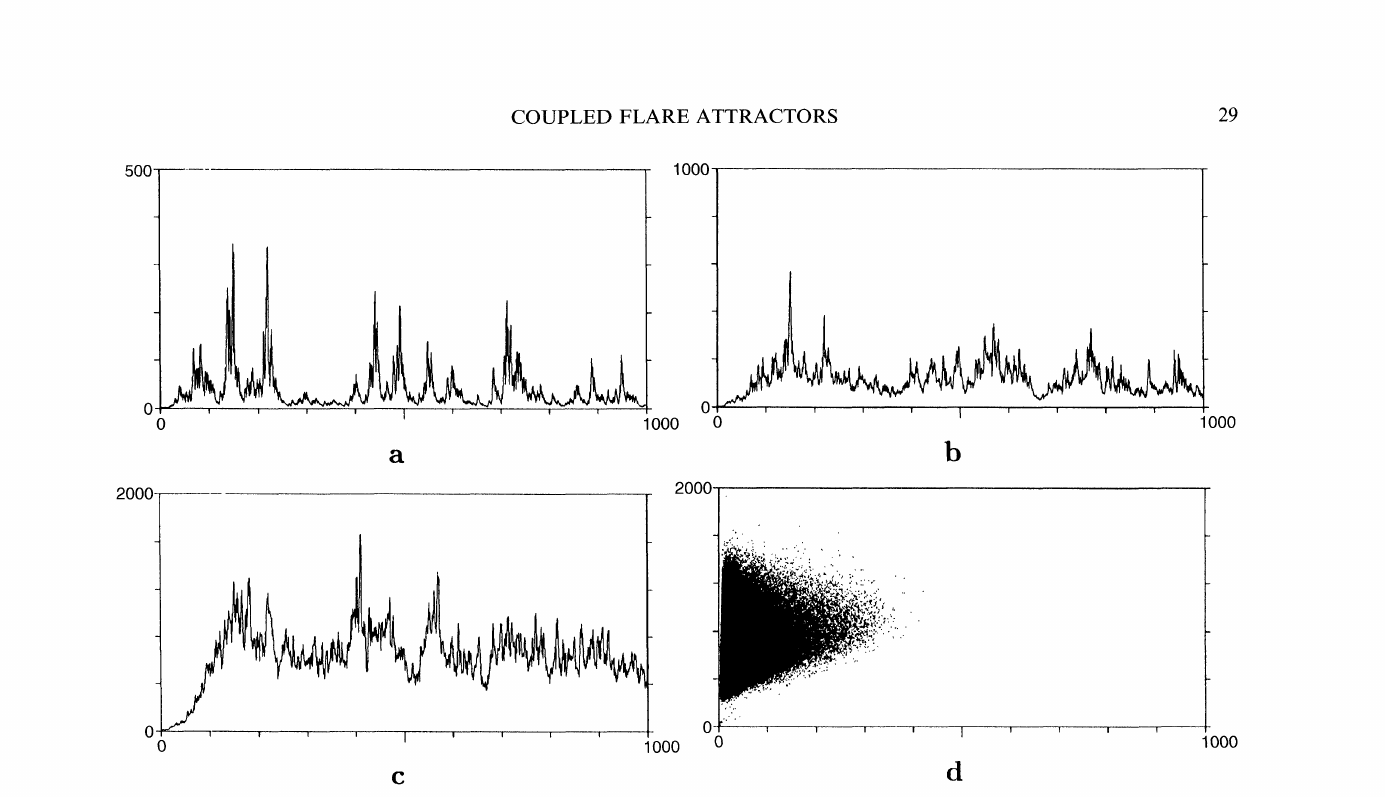
FIGURE 4 Several coupled flare attractors, superposed. Numerical simulation of Eq. (3). (a) Time plot of b (1). A very similar picture was by the way obtained if the last term in the second line of Eq. (3) was replaced by a constant, 0.6. (b) Time plot of b O) through b (6), superposed. (c) Time plot of b (1) through b (18), superposed. (d) b (), s plot, 000000 iterations shown. Initial conditions for the first variables x(J): 0.010, 0.011, etc.; for the second variables b(J):